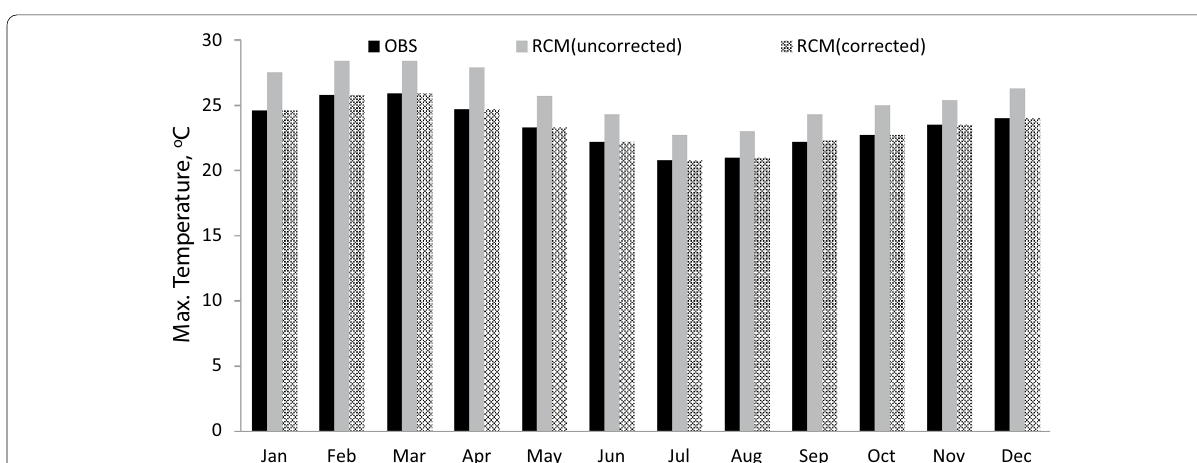
Fig. 4 Comparison of bias corrected and uncorrected RCM data of maximum temperature on the monthly basis